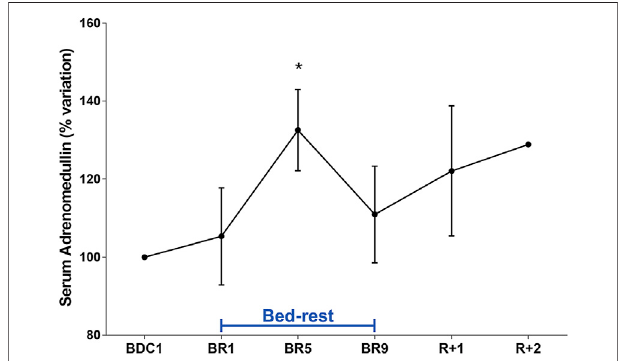
FIGURE 6 | Serum Adrenomedullin (ADM) (% variation vs. BDC1) during 10-daybedrest.Dataareexpressedasmean±S.E.M.Statisticalanalysiswas done using One Sample t test (* p < 0.05 for BR5 vs.